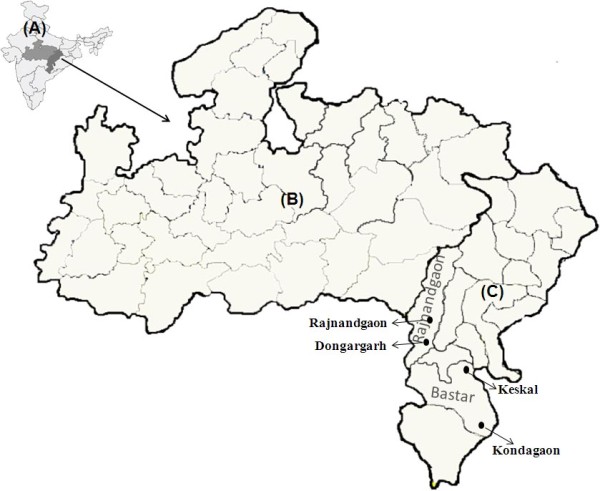
(A) Map of India (B) Madhya Pradesh (C) Chhattisgarh showing study area.